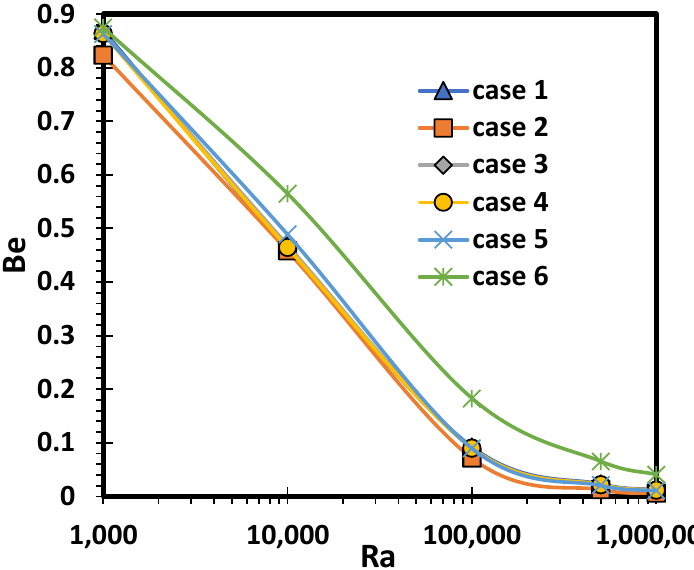
Figure 16. Bejan number for various heat source positions and different Ra.